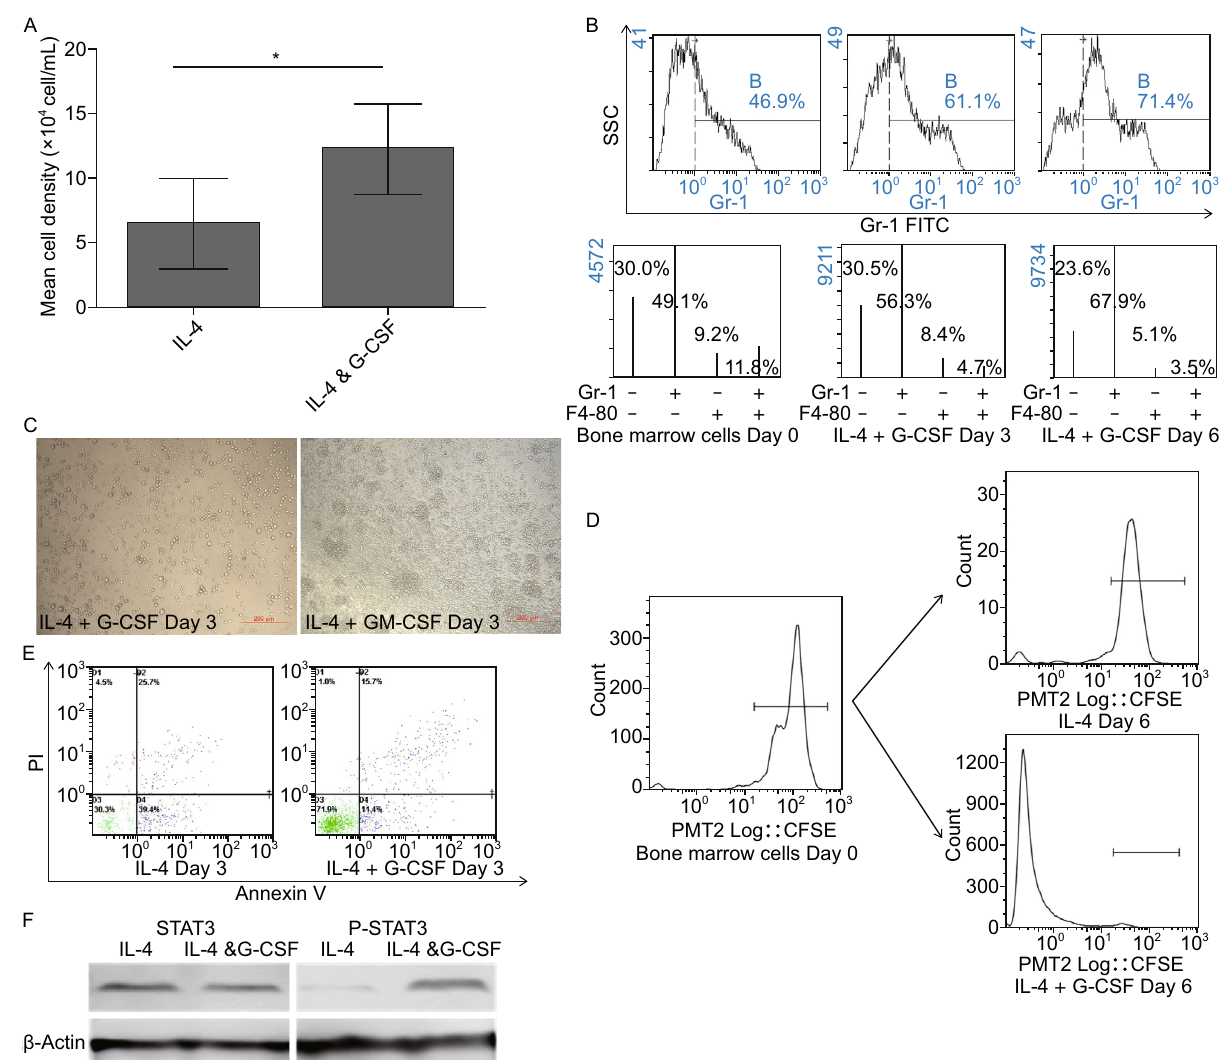
Figure 4. In vitro study of MDSC regulated by G-CSF. (A) The in vitro study of MDSC recruited by G-CSF. MDSCs isolated from bone marrow went through a transwell membrane toward the media with IL-4 alone or IL-4/G-CSF combination for 4 h. (B – C) MDSCs isolated from bone marrow were cultured with IL-4 alone or the combination of IL-4/G-CSF for 6 days. Flow cytometric analysis of Gr- 1 and F4/80 markers expressed in the cell surface of MDSCs. (D) CFSE proliferation assay. MDSCs isolated from bone marrow were incubated with CFSE previously, and then cultured with IL-4 lone or IL-4/G-CSF combination for 6 days. (E) MDSCs cultured with IL-4 lone or IL-4/G-CSF combination for 6 days, and then the apoptotic fraction was determined by using Annexin V-PE and PI fl uorescences measured by a fl ow cytometer. (F) Western blot detection of pSTAT3 in G-CSF activated MDSCs. Equal loading is visualized by β -actin